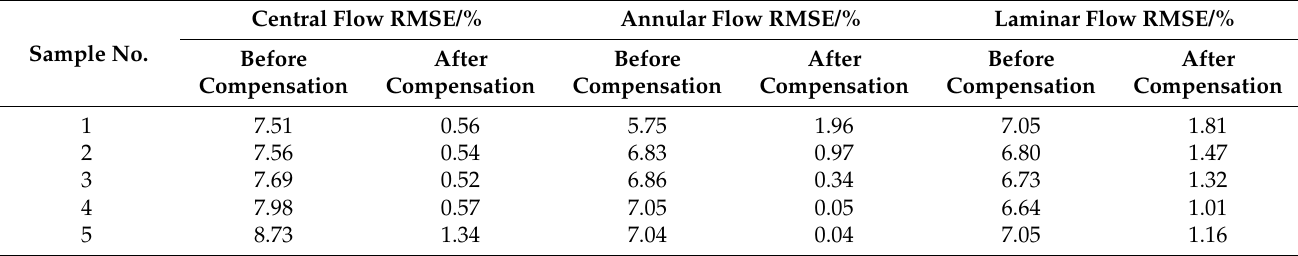
Table 4. The relative mean square error between the measured value of the non-uniform sensor before and after compensation and the measured value of the fully uniform